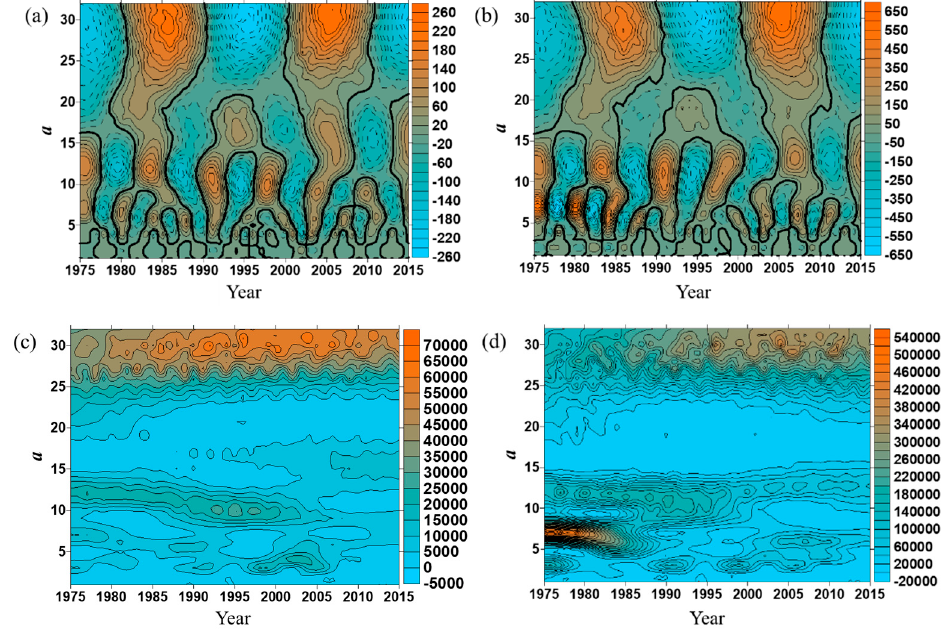
Figure 6. Inflow runoff and sediment anomaly series of wavelet coefficient contour map. ( a ) Real part contour map of runoff; ( b ) Real part contour map of sediment; ( c ) Modular square contour map of runoff; ( d ) Modular square contour map of sediment. Where, a is the time scale.